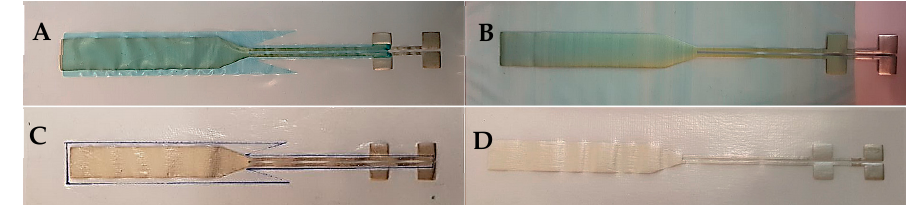
Figure 2. The screen-printed stretchable interconnects with different encapsulation materials. ( A ) Partially dielectric ink-coated, ( B ) entirely dielectric ink-coated, ( C ) partially thermoplastic polyurethane (TPU) heat-laminated, and ( D ) entirely TPU heat-laminated interconnect.